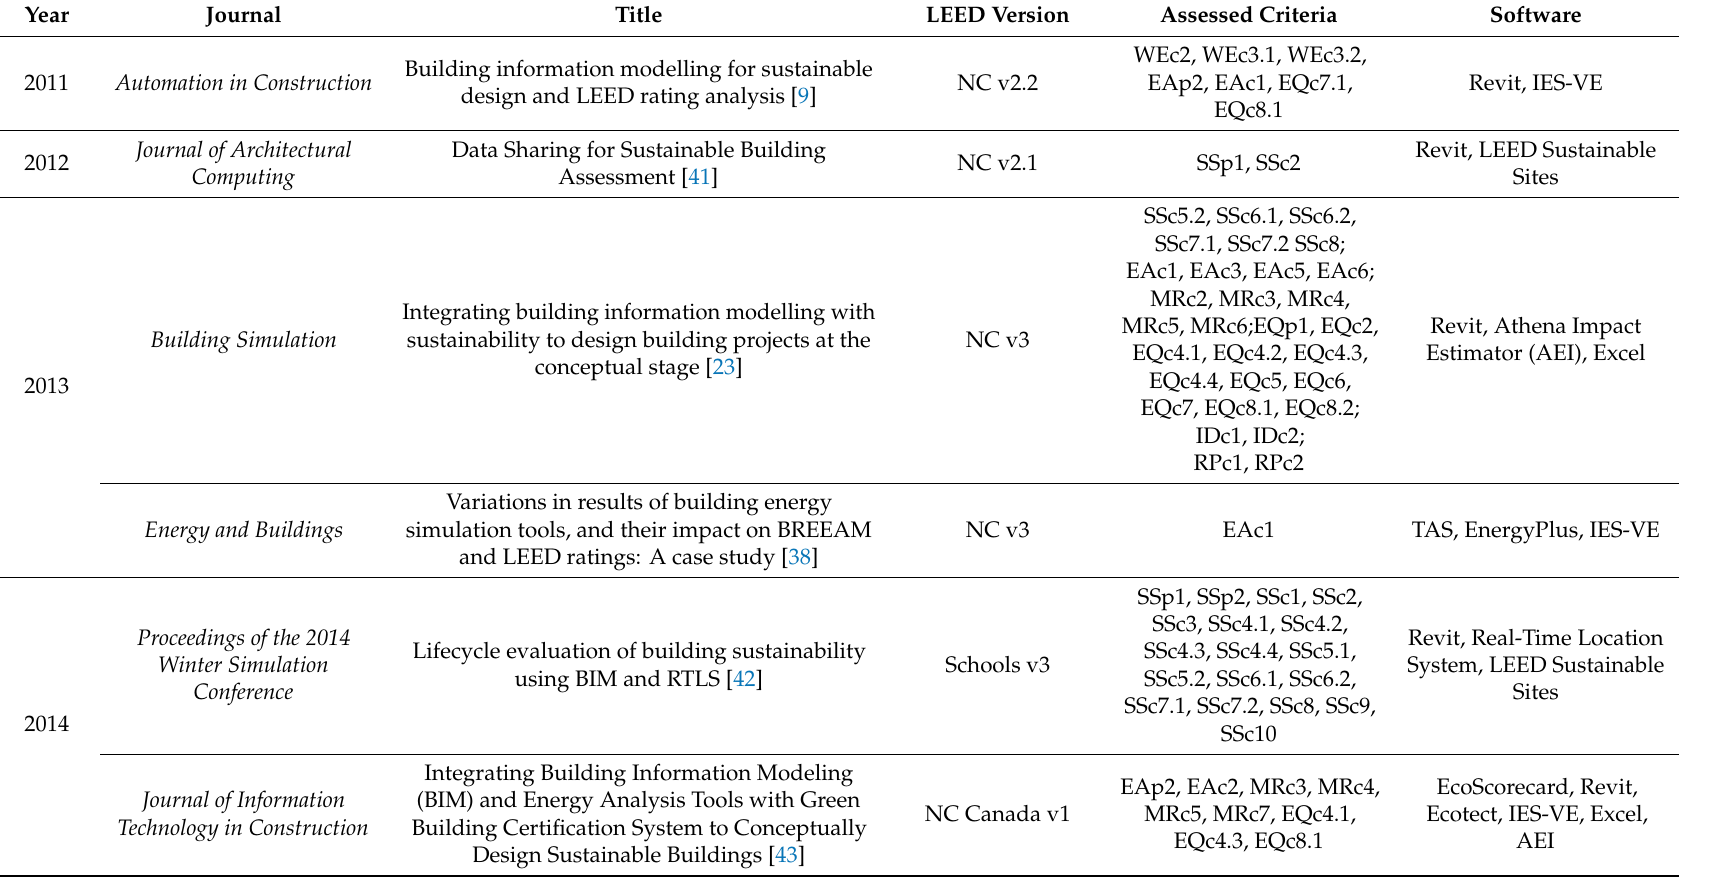
Table 3. BIM integration on